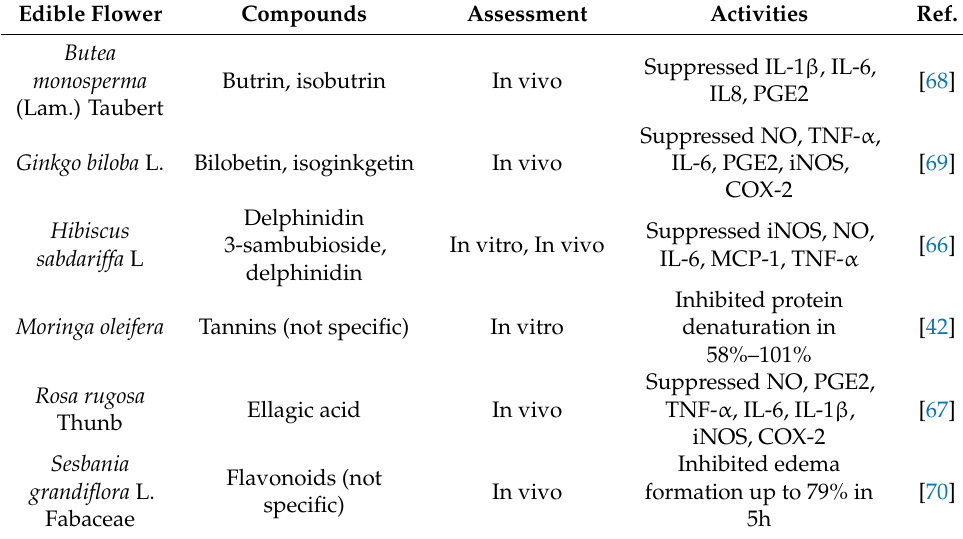
Table 3. Anti-inflammatory activities in edible